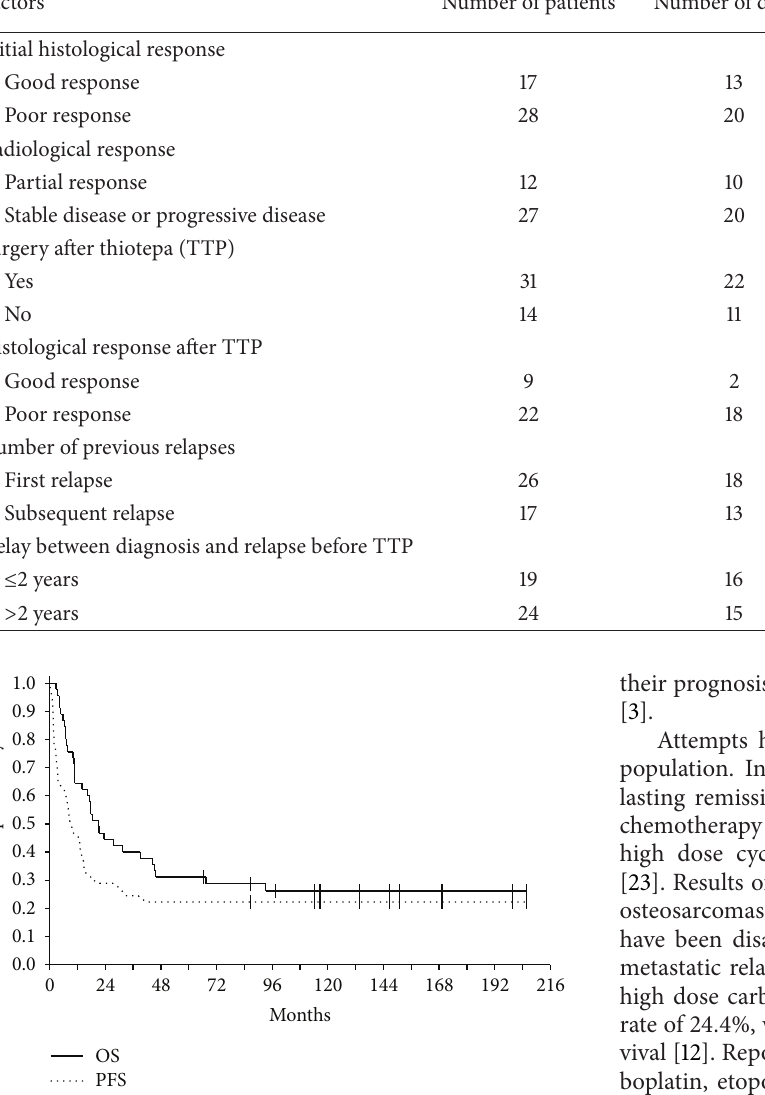
Figure 2: Progression-free (PFS) and overall (OS) survival of 45